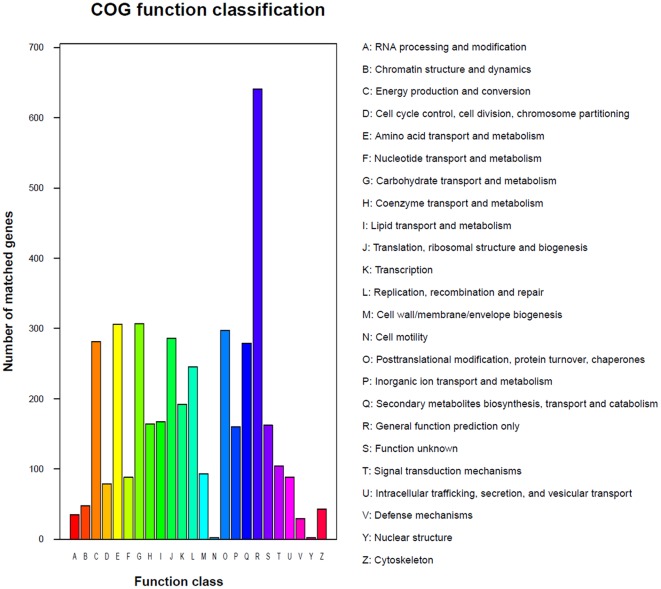
The COG function annotaion of G. lucidum.Distribution of Genes in different COG function classification.